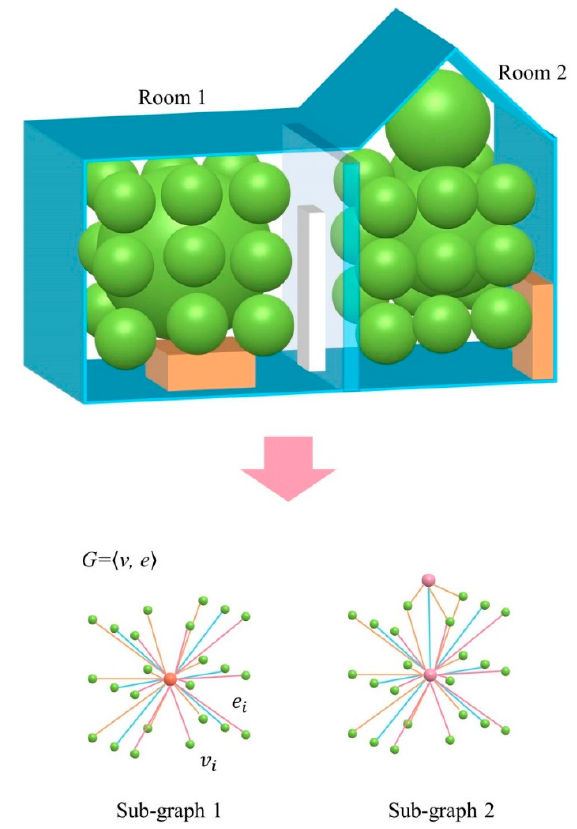
Figure 3. Inner sphere packing of the indoor space and constructed graph.